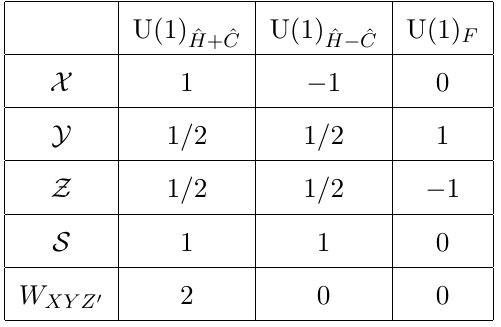
Table 2 . Global symmetry charges for the N = 4 SQED version of the